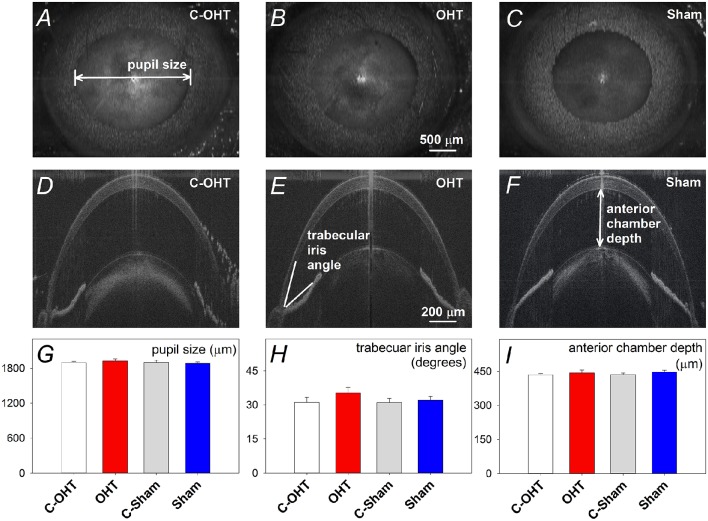
Effect of circumlimbal suture and chronic intraocular pressure (IOP) elevation on the mouse anterior segment. (A–C) Representative en face images of an ocular hypertensive (B. OHT), its fellow control (A. C-OHT) eye, and a sham operated eye (C. Sham) at week 12, acquired during anterior segment imaging allowing pupil diameter to be quantified. (D–F) Sagittal optical coherence tomography images of the anterior chamber for an OHT (E), its control eye (D), and a sham operated eye (F). (G) Averaged (± SEM) pupil size for OHT (n = 23, red), C-OHT (unfilled) as well as Sham (n = 17, blue), and their contralateral control eyes (C-Sham, gray). (H) Average trabecular meshwork-iris angle (TIA). (I) Average anterior chamber depth.